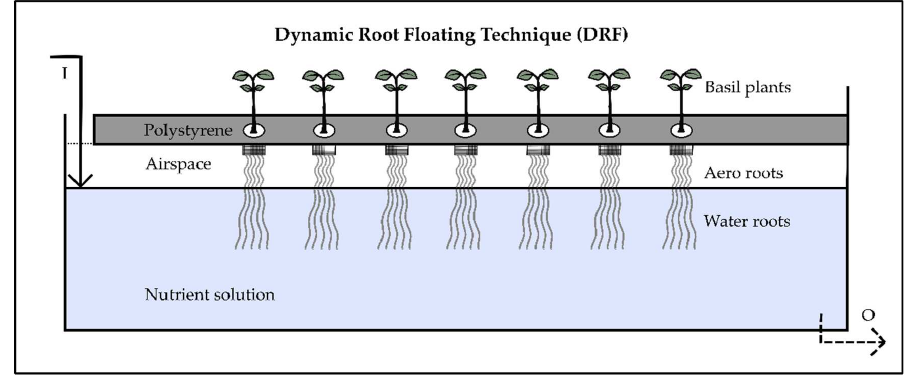
Figure 2. Schematic illustration of the dynamic root floating (DRF) system with air space of 5 cm. I = inflow, O = outflow.